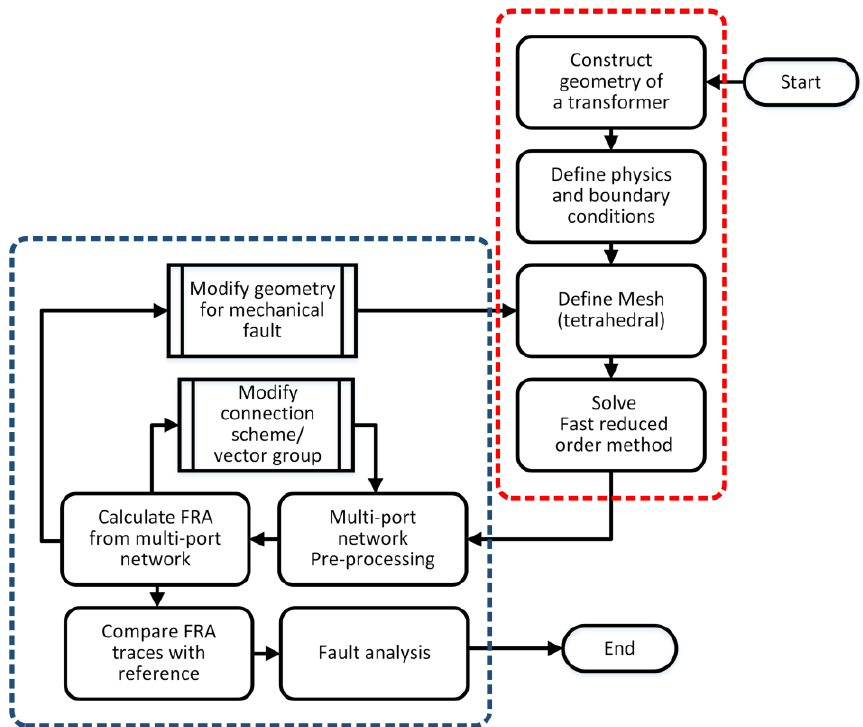
Figure 5. FRA simulation algorithm in CST, design module tasks (red), schematic module tasks (blue).